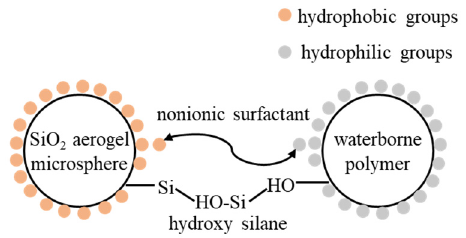
Figure 3. The schematic of dispersion mechanism of SiO 2 aerogel.